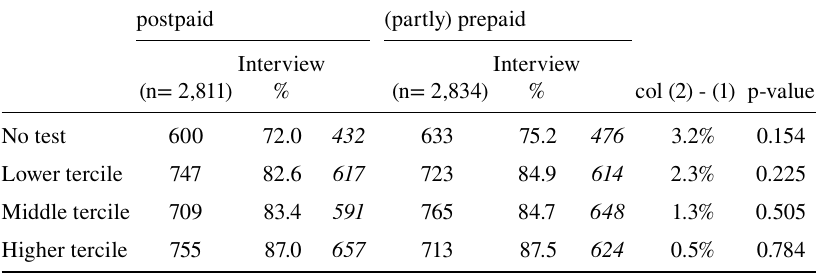
Table A2 Wave 6 Response Rates by Mathematics Proficiency (N=